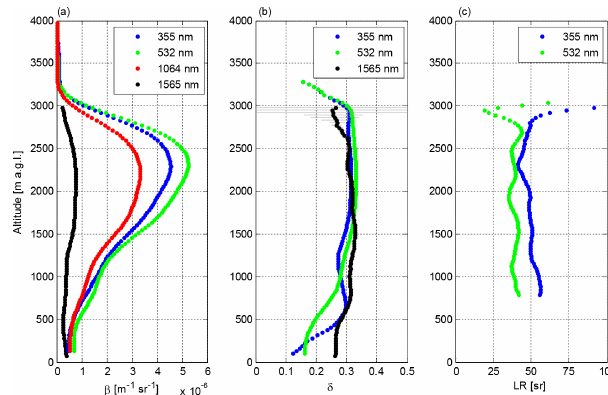
Figure 8. Averaged profiles at Limassol on 27 April 2017 at 19:00– 20:00UTC. All profiles have been smoothed by a 300m running mean. (a) Backscatter by PollyXT (wavelengths 355–1064nm) and attenuated backscatter by Halo (1565nm). (b) Particle linear de- polarization ratio. Error bars represent measurement uncertainty. (c) Lidar ratio. For PollyXT β 355 and β 532 , a near-range telescope is used for data < 900ma.g.l.